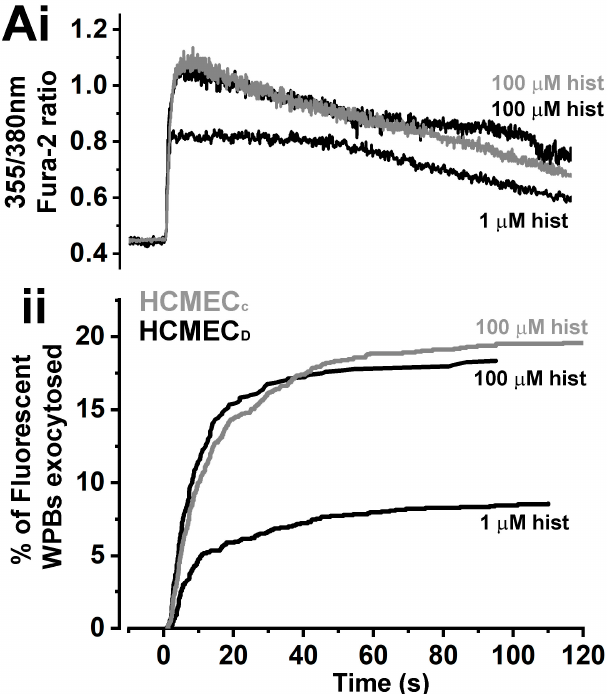
Figure 7. Kinetics of histamine-evoked WPB exocytosis in HCMEC D and HCMEC C . ( Ai ) Presenta- tive records of the changes in Fura-2 fluorescence-ratio (355 nm/380 nm) in single HCMEC D and HCMEC C during stimulation with 1.0 or 100 µM histamine as indicated. For comparison, the Fura- 2 traces were offset so that the increase in [Ca 2+ ] i in each case occurred at time = 0. ( Aii ) Cumulative plots of WPB fusion events normalised by their total number in VWFpp-eGFP expressing HCMEC D (black traces; 1 µM; n = 141 fusion events, 11 cells, 100 µM; n = 196 fusion events, 10 cells) or HCMEC C (grey trace, 100 µM; n = 300 fusion events, 14 cells). HCMEC; human cardiac microvascu- lar endothelial cells ( C ; control, D ; dilated cardiomyopathy). WPB; Weibel–Palade body. VWFpp- eGFP; von Willebrand factor propeptide-eGFP.